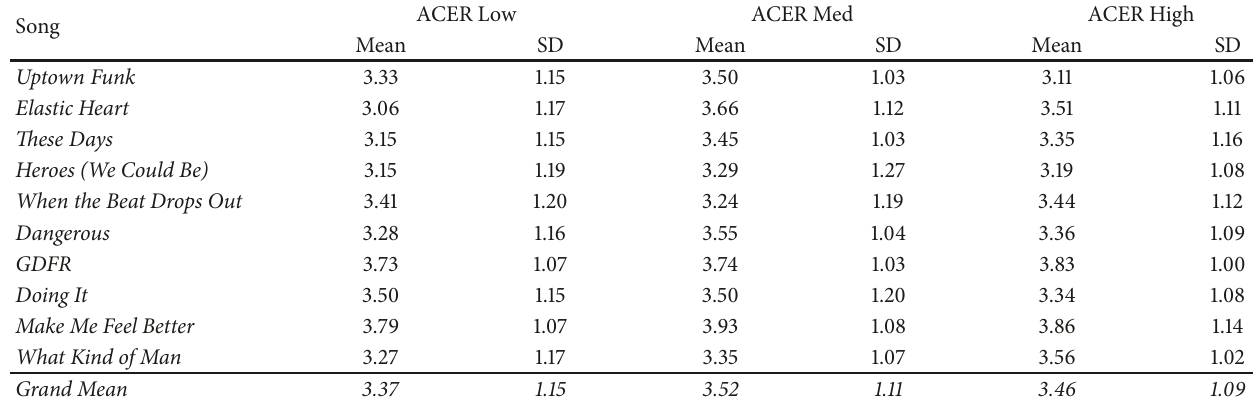
Table 7: Summary stereo image scores: ACER low, ACER medium, and ACER high 192 (n=63). A score of 1 represents narrow and imprecise and a score of 5 represents wide and precise noise and distortions.